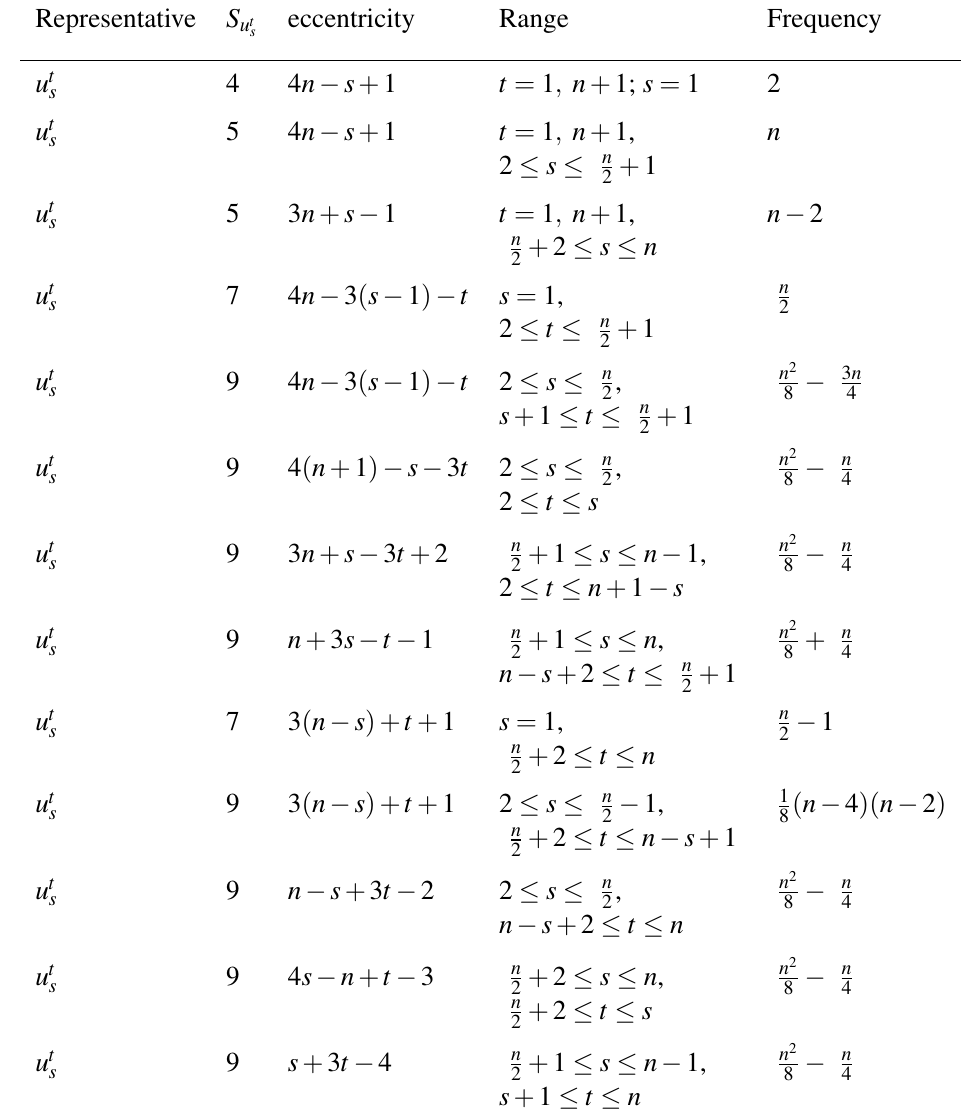
Table 1 Partition of vertices of the type u t mod 2 )